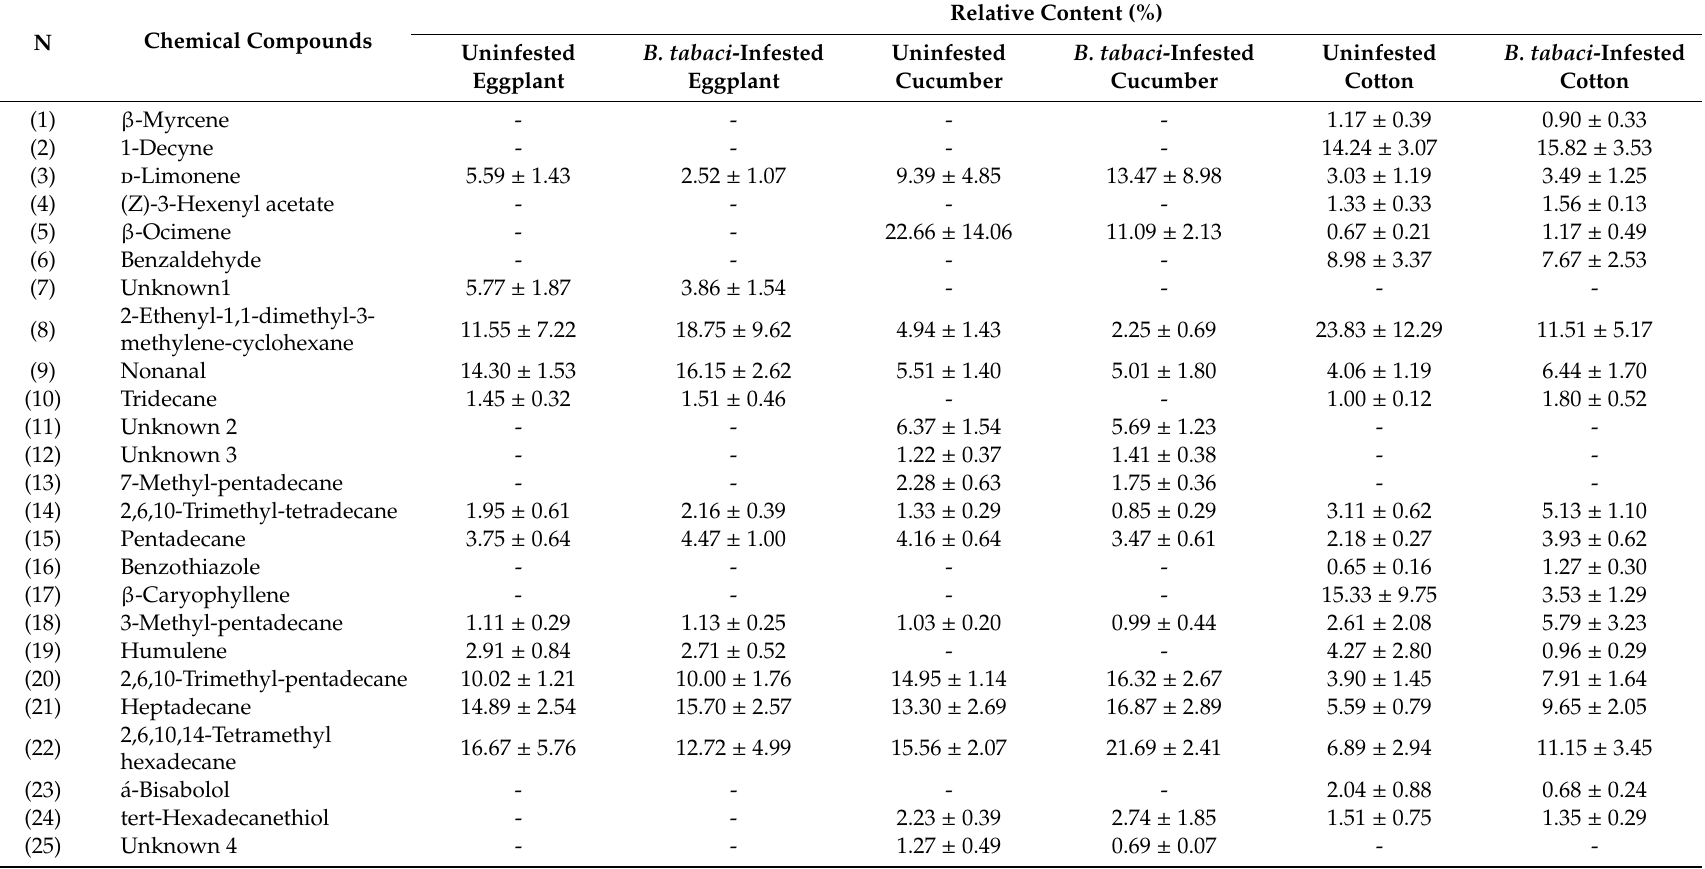
Table 1. Relative contents (mean ± SE) of volatiles from uninfested and B. tabaci -infested plants that were preferred by Serangium japonicum